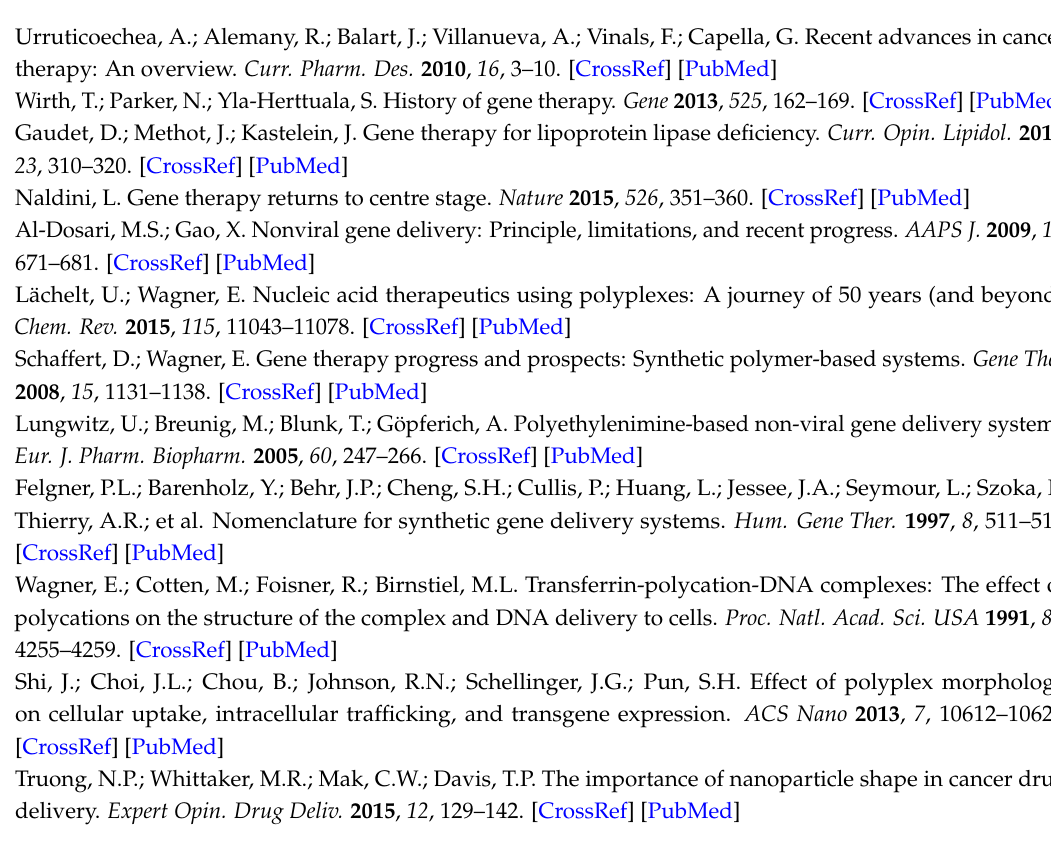
spectrum of #1088, Figure S10: RP-HPLC spectrum of #1088, Figure S11: 1 H-NMR spectrum of #1091, Figure S12 RP-HPLC spectrum of #1091, Figure S13: 1 H-NMR spectrum of #1120, Figure S14: RP-HPLC spectrum of #1120, Figure S15: 1 H-NMR spectrum of #1094, Figure S16: RP-HPLC spectrum of #1094, Figure S17: 1 H-NMR spectrum of #1097, Figure S18: RP-HPLC spectrum of #1097, Figure S19: 1 H-NMR spectrum of #1078, Figure S20: RP-HPLC spectrum of #1078, Figure S21: 1 H-NMR spectrum of #996, Figure S22: RP-HPLC spectrum of #996, Figure S23: 1 H-NMR spectrum of #442, Figure S24: RP-HPLC spectrum of #442, Figure S25: 1 H-NMR spectrum of #694, Figure S26: RP-HPLC spectrum of #694, Figure S27: 1 H-NMR spectrum of #1000, Figure S28: RP-HPLC spectrum of #1000, Figure S29: 1 H-NMR spectrum of #901, Figure S30: RP-HPLC spectrum of #901, Table S1: Average sizes of oligomers (Number mean), Table S2: List of c-Met targeted